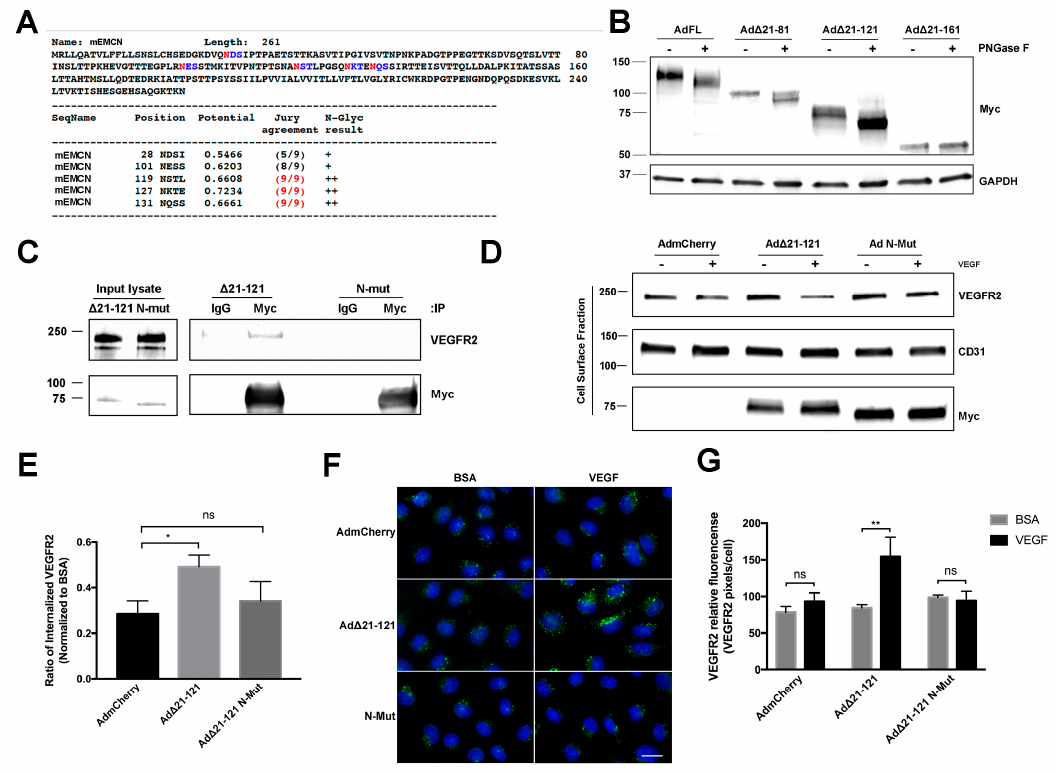
Figure 5. N -glycans on EMCN ECD are essential for EMCN’s role in VEGFR2 signaling. ( A ) Potential N -glycosylation sites (asparagine, N, red) on full-length mEMCN predicted by NetNGlyc 1.0 Server. ( B ) Molecular weight of FL EMCN, Δ 21-81 EMCN, Δ 21-121 EMCN, and Δ 21-161 EMCN with and without PNGase F digestion were examined by western blot; GAPDH was included as loading control. Observed molecular weights are in aligned with predicted sizes. ( C ) Membrane proteins of HRECs (lacking endogenous hEMCN) expressing Myc-tagged EMCN Δ 21-121 EMCN or Δ 21-121 EMCN with N -glycan sites mutated (N-Mut) were co-IP’ed for using anti-Myc and examined by western blot. The mutant lacking N -glycosylation did not bind to VEGFR2. ( D ) HRECs lacking endogenous hEMCN and expressing either Δ 21-121 EMCN or N-Mut were used to examine cell surface expression of VEGFR2 by biotinylation. As seen for the co-IP, the Δ 21-121 lacking N -glycosylation was unable to rescue VEGFR2 internalization compared to the normally glycosylated EMCN mutant. ( E ) Quantification shows reduced VEGFR2 internalization in the absence of N -glycosylation. * p < 0.05 by 2-tail unpaired t-test, n = 4. ( F ) Immunocytochemical assay to detect internalized VEGFR2 proteins in HRECs stimulated with VEGF or BSA: Consistent with the findings in Figure 5D,E, Δ 21-121 EMCN was able to rescue VEGFR internalization where the N -glycosylation mutant was not. Scale bar: 20 μ m. ( G ) Internalized VEGFR2 was quantified as total VEGFR2-positive pixels divided by the total number of cells per images. Data = mean ± SEM, ns, not significant, ** p < 0.01 by 2-tail unpaired t-test, n = 6.